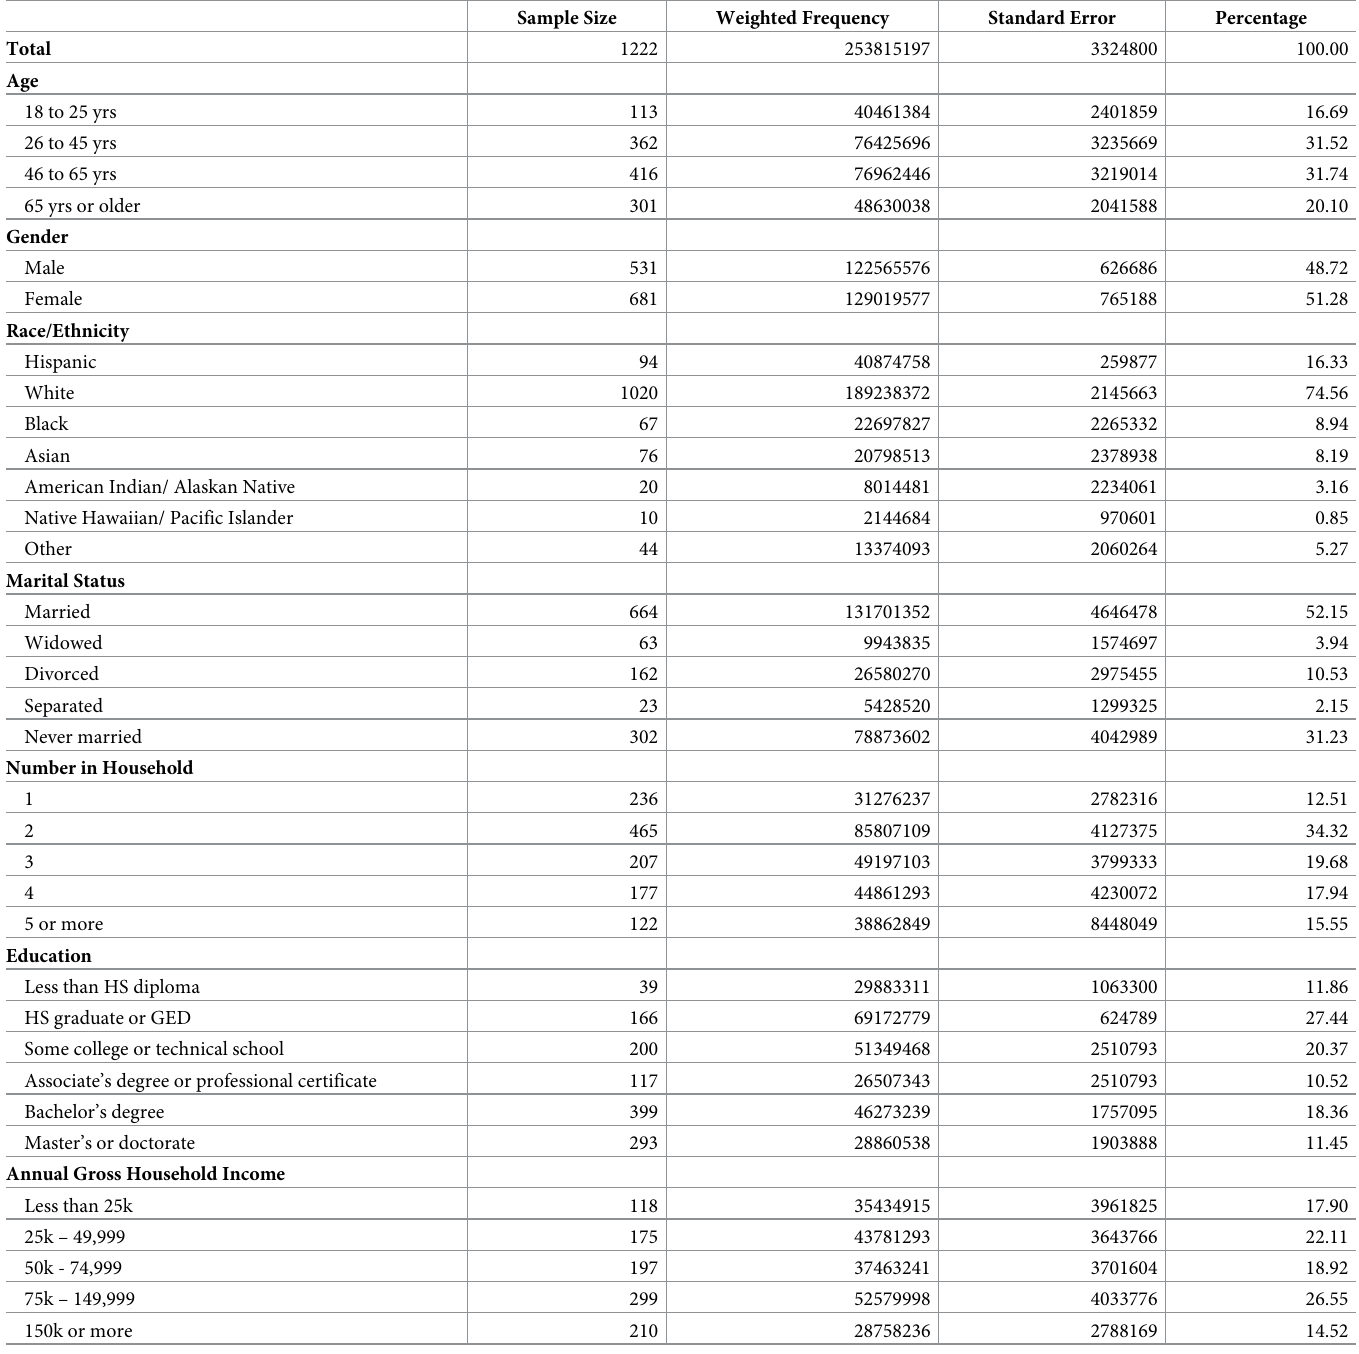
Table 1. Demographics